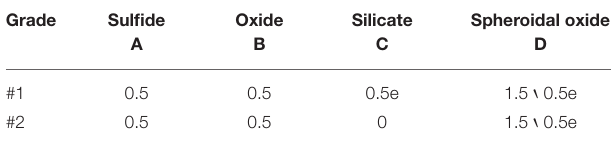
TABLE 3 | Grade of non-metallic inclusions in CB10